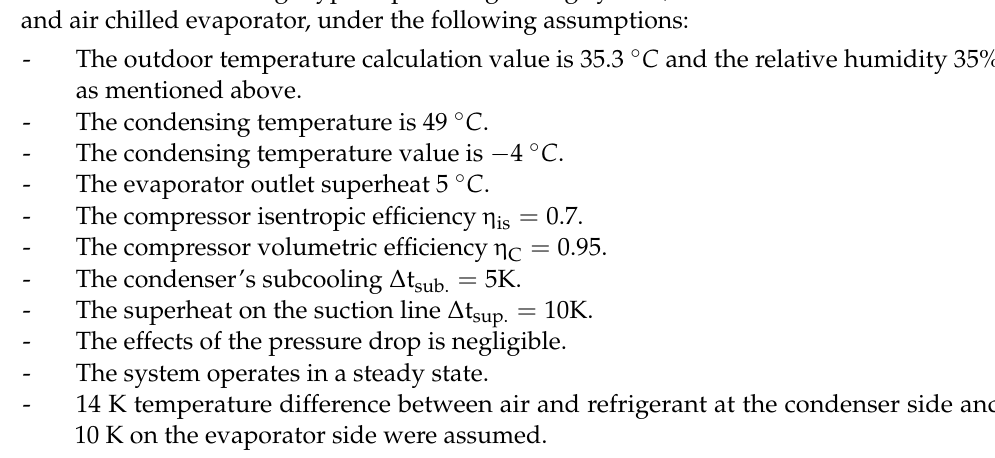
Table 2. Refrigerant properties.